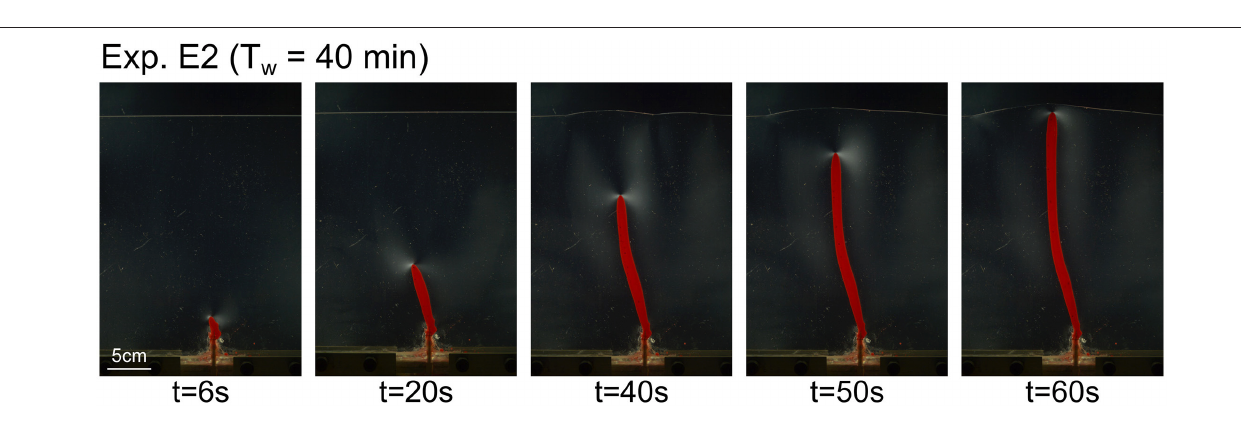
FIGURE 5 | Time series of polarized light photographs of Experiment E2 ( T w = 40